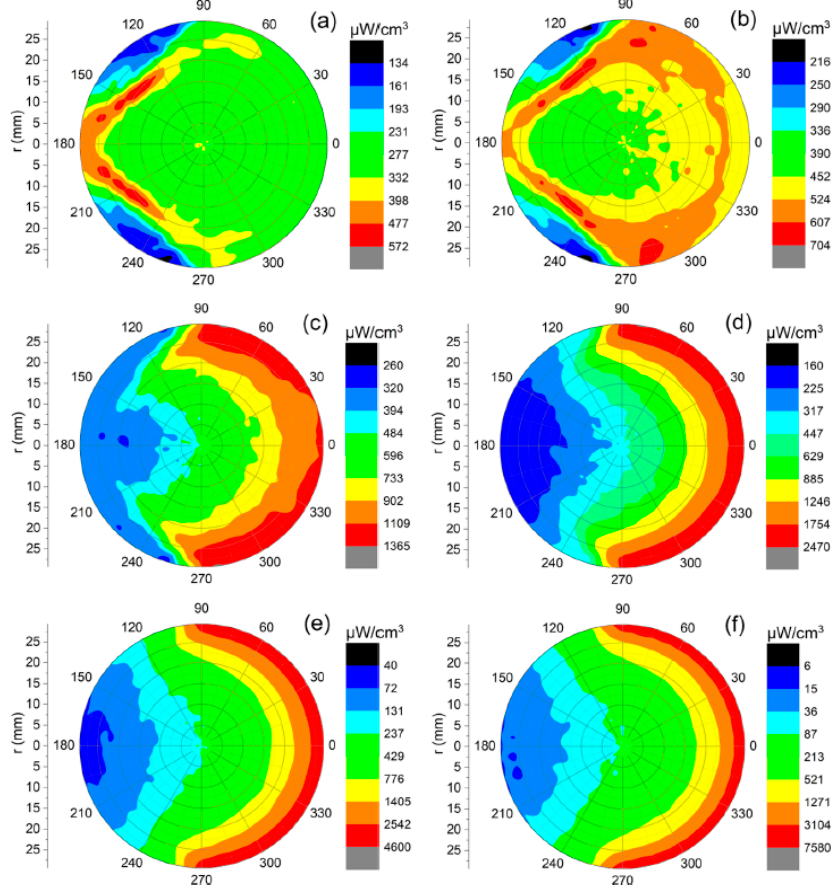
Figure 5. Polar plots of LVREA at different photocatalyst loadings: ( a ) 0.005; ( b ) 0.01; ( c ) 0.025; ( d ) 0.05; ( e ) 0.1; ( f ) 0.2 g/L. Reprinted with permission from [27]. Copyright American Chemical Soci-